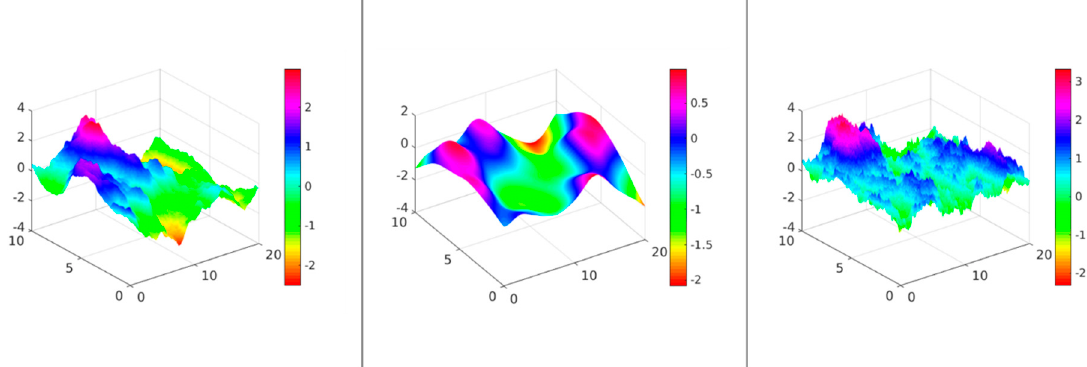
Figure 14. Three surfaces with the same roughness parameters ( R a = 0, R ma = 0.797, R sq = 1, R sk = 0 and R ku = 3) with different fractal dimension DF = 9/4 ( left ), DF = 8/4 ( middle ), and DF = 11/4 ( right ).